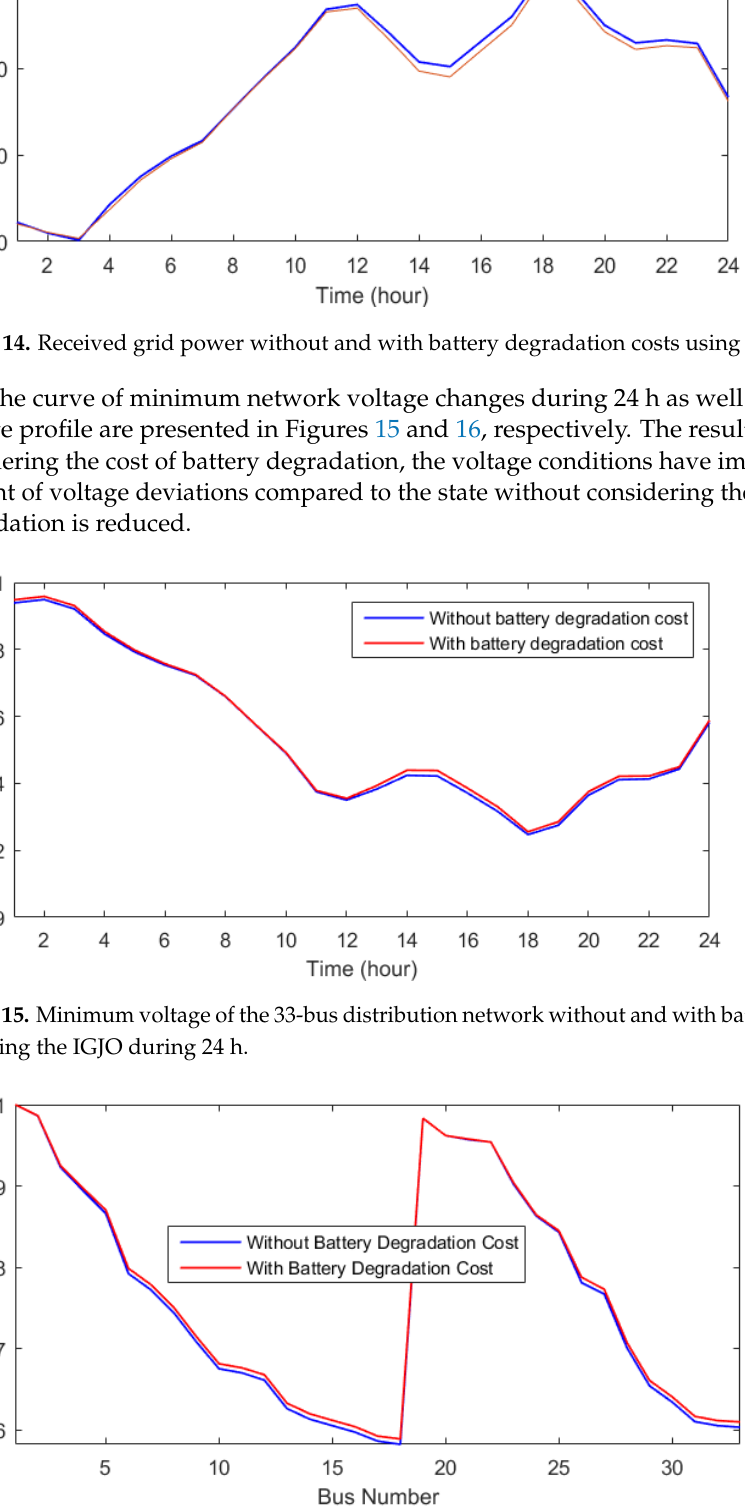
Figure 16. Voltage profile of the 33-bus distribution network without and with battery degradation costs using the IGJO.